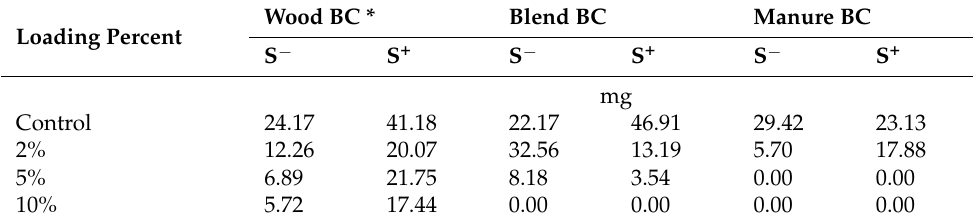
Table 13. Median total nitrogen content for Trifolium incarnatum